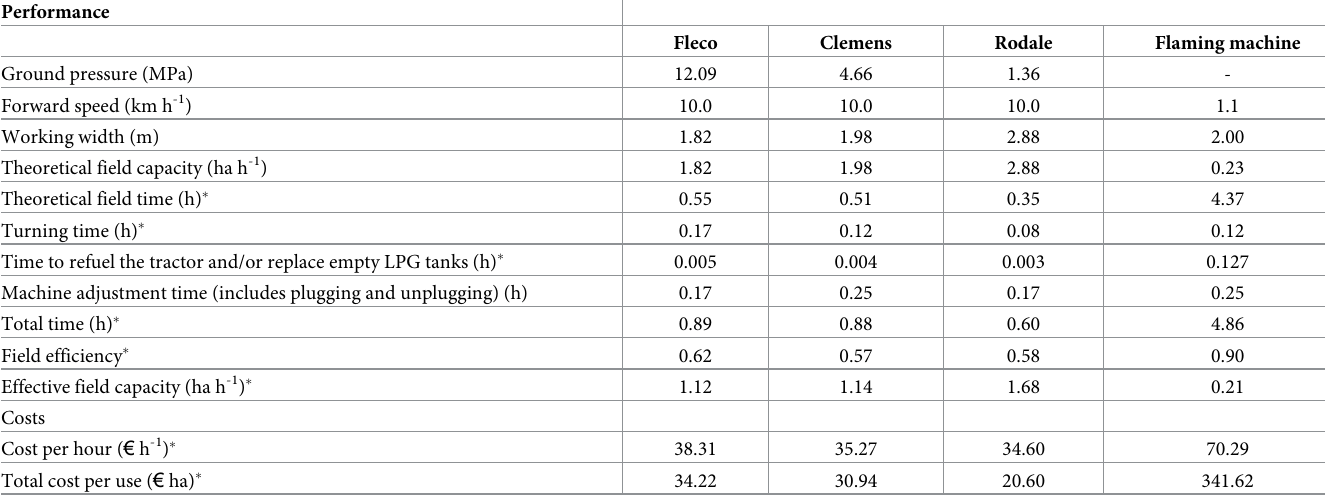
Table 3. Roller crimpers and flaming machines performance and costs estimation. All machines were used coupled with a New Holland TL100 tractor.